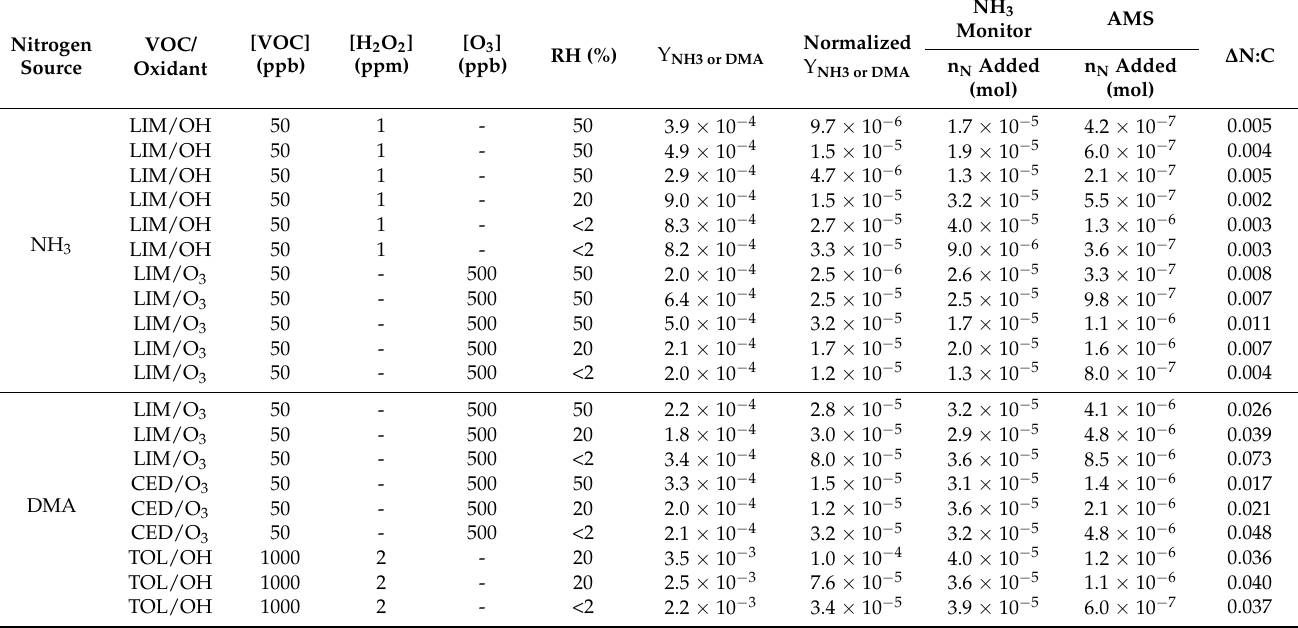
Table 1. Summary of chamber conditions for experimental trials performed. LIM = d-limonene, CED = α -cedrene; TOL = toluene. The column with γ values lists total uptake coefficients determined from Equation (1). The n N columns list the calculated increase in moles of N in the particles after exposure to NH 3 or DMA calculated from the monitor data (Equation (3)) and AMS data (Equation (4)). The increase in N:C ratio 2 h after the injection of NH 3 or DMA is reported